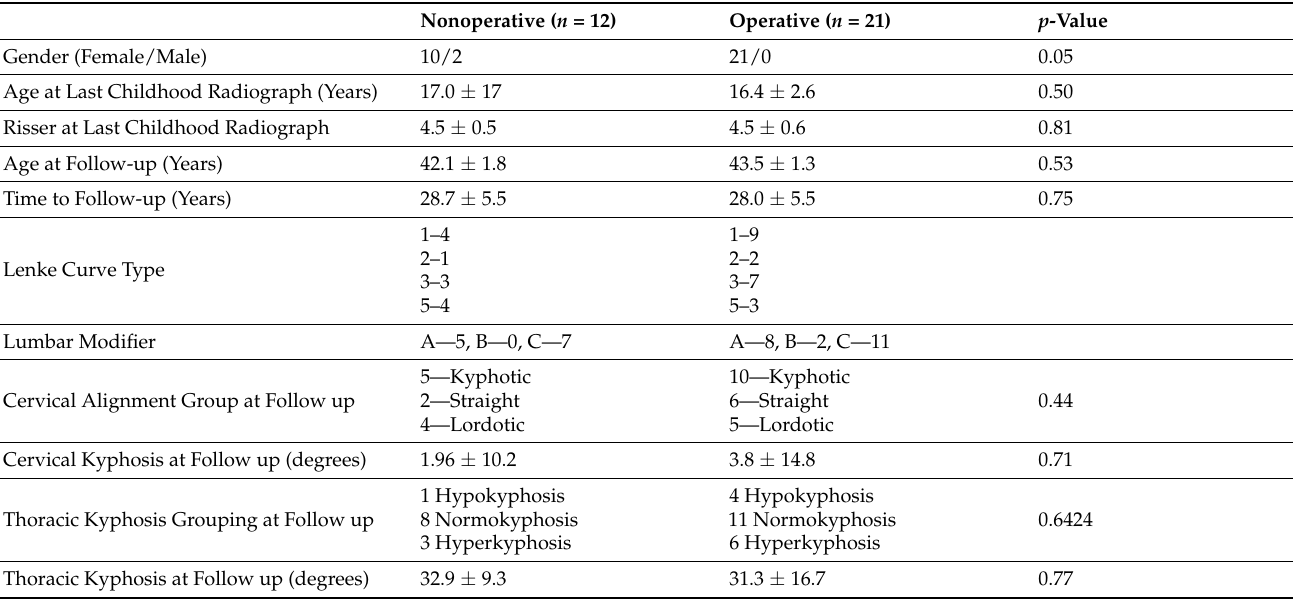
Table 1. Comparison of nonoperative and operative cohort at follow